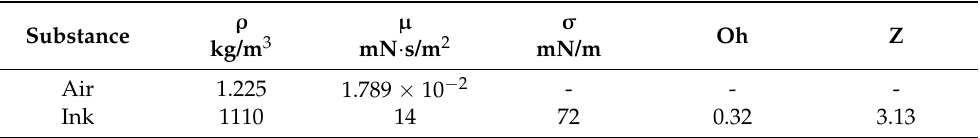
Table 1. Physical parameters of the substances used in the numerical modeling of the inkjet printhead